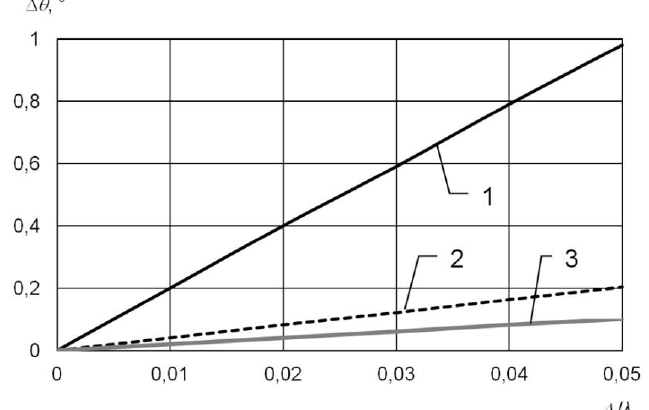
Fig. 6. Angular displacement of PAA difference radiation pattern minimum from a given direction of the deflected beam depending on the radiators basing error.